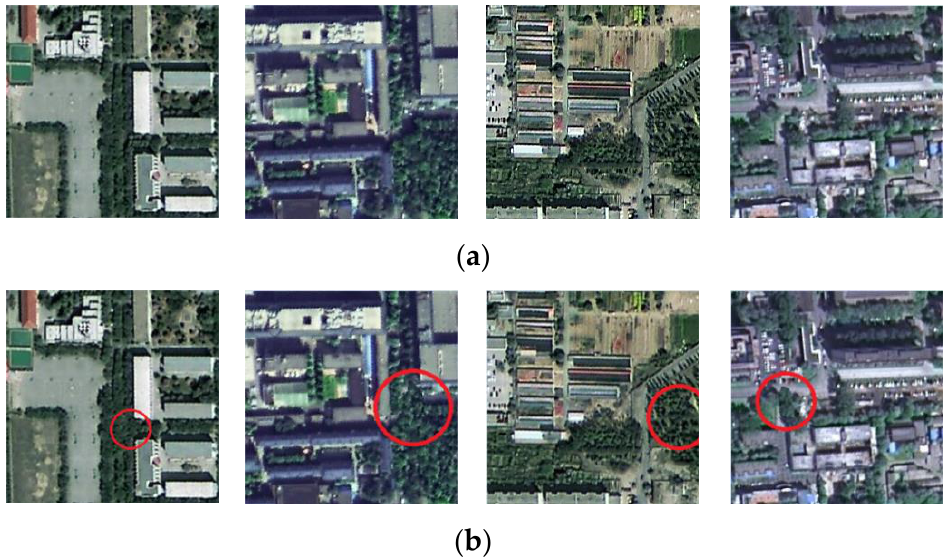
Figure 12. Examples of the subject unrelated tampering: ( a ) Original HRRS images, ( b ) subject unrelated tampering. Table 7. Omission factor of sensitivity to tampering with subject unrelated changing.